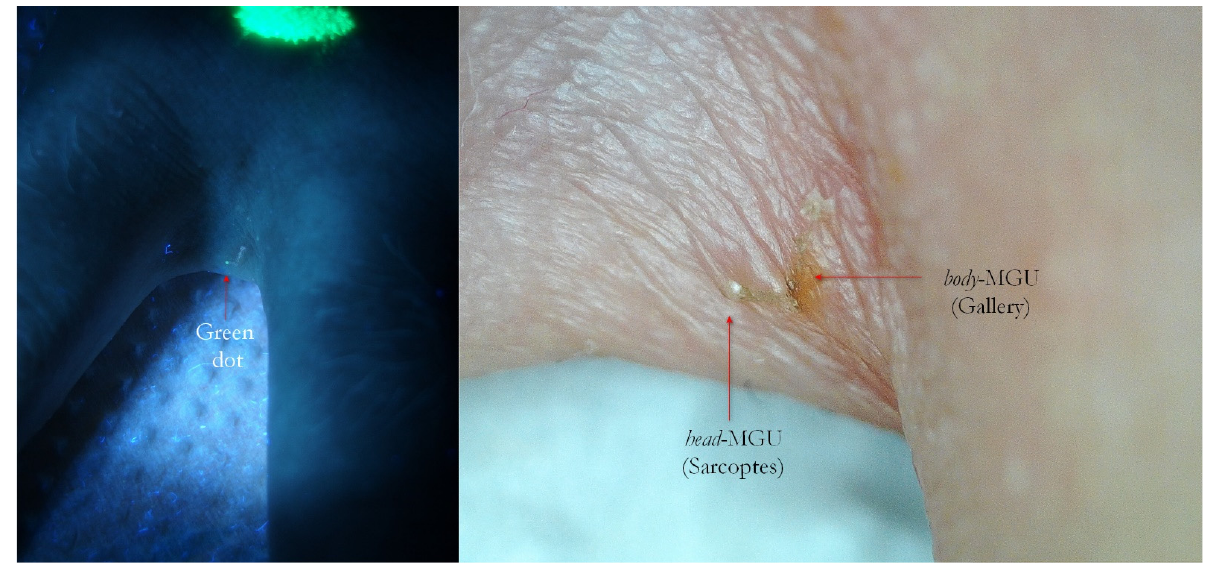
Figure 12. Scabies of interdigital fold of hand. Interdigital MGU under UVA exhibited a green dot (left red arrow). A bright blue luminescent fabric thread was nearby. Dry dermoscopy of same MGU confirmed Sarcoptes and its gallery (right, red arrows), but site anatomy made it difficult to obtain all ‐ in ‐ focus image. A yellow highlighter was used. coptes resides, was called “white dot” (Figures 5 and 13).